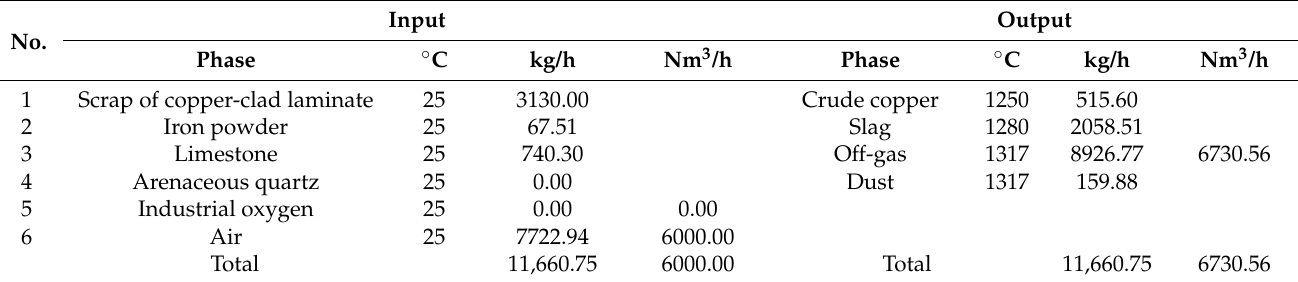
Figure 4. The interface of the thermodynamic simulation system for the top-blown smelting process of electronic waste. Table 4. The input–output material balance in the NRT smelting of electronic